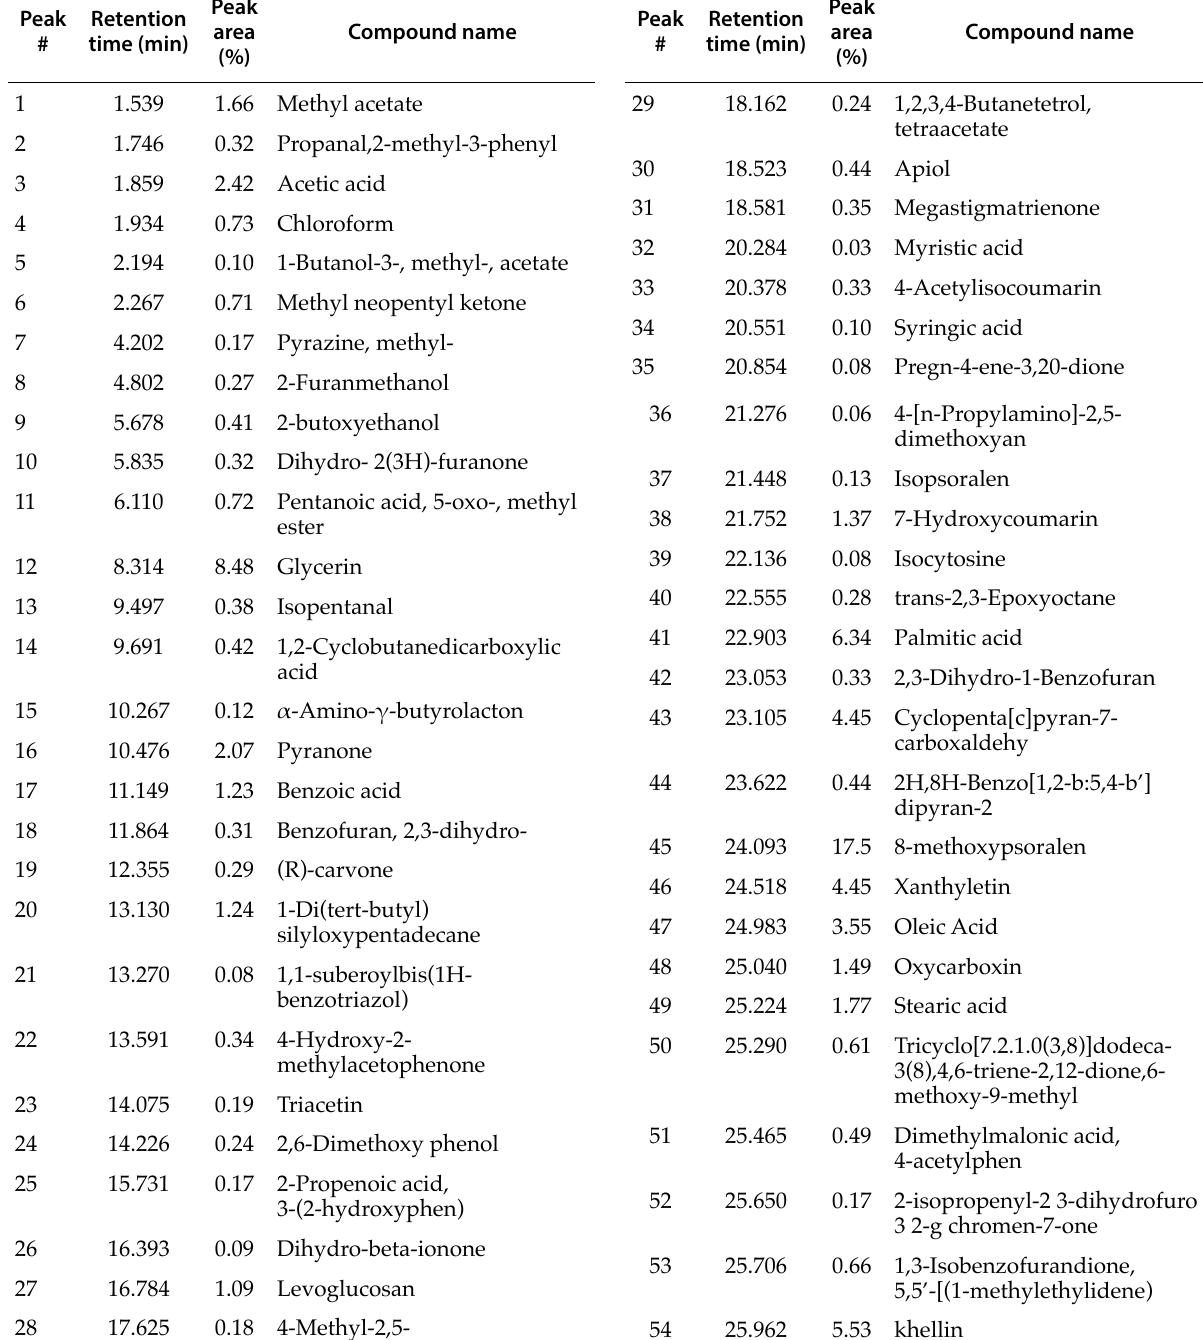
Table 5. Chemical constituents of the methanol extract of khella, determined using GC-MS. Peak